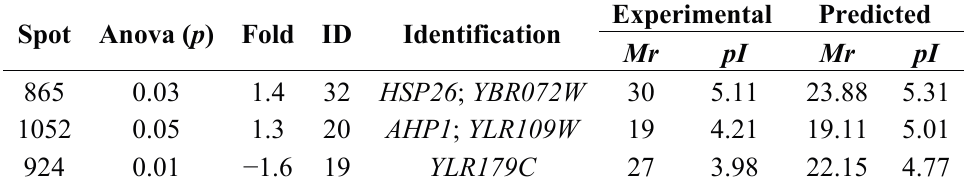
Spot, master protein spot number according to Figure 1A–D; ID, identification protein number. ID correspond to the red numbers (between brackets) in Figure 1; Fold = Average volume ratio, positive is fold increment and negative is fold decrement; Experimental Mr (kDa) and pI calculated by analysis of the gel images as explained in the text. Predicted Mr and pI according to protein sequence and Mascot search